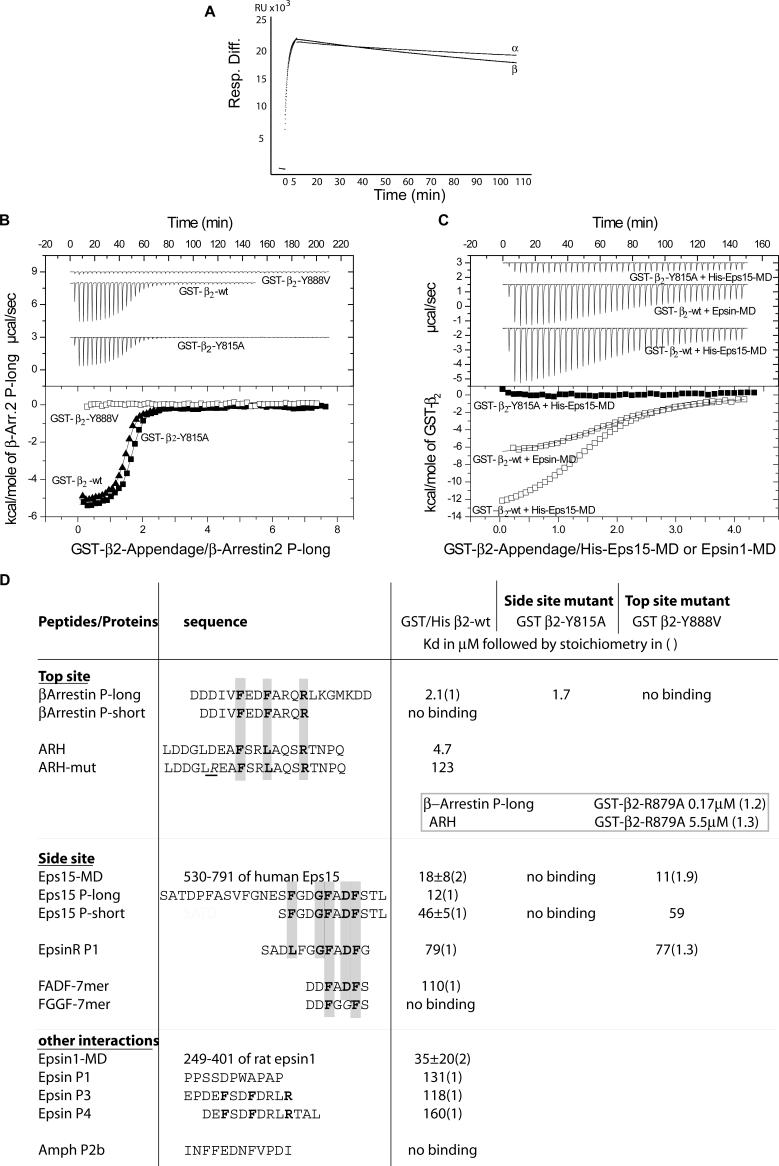
High Avidity Interactions of Eps15 for Clustered Appendages, yet Low Affinity Interactions of Ligands with Isolated Appendages(A) Surface plasmon resonance measurements of Eps15-MD binding α and β-appendages. Note that the protein binds, but does not come off even after extensive washing.(B) Affinities of β-arrestin P-long (see D) for wild-type β2-appendage and mutants measured by ITC.(C) Affinity measurement of protein domains with β2-appendages.(D) Table of peptides used, highlighting possible motifs, and a summary of affinities.